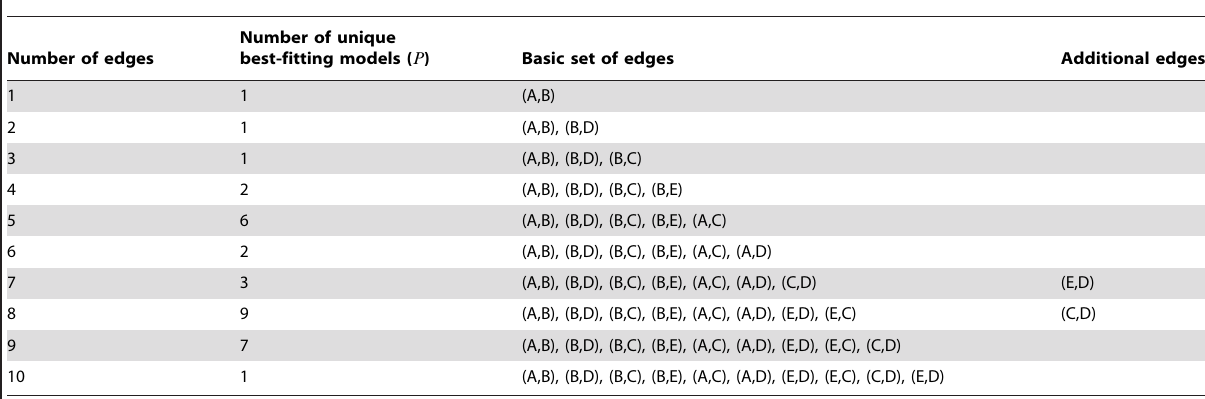
Table 5. Edges present in the best-fitting models in rat (BIC scores).